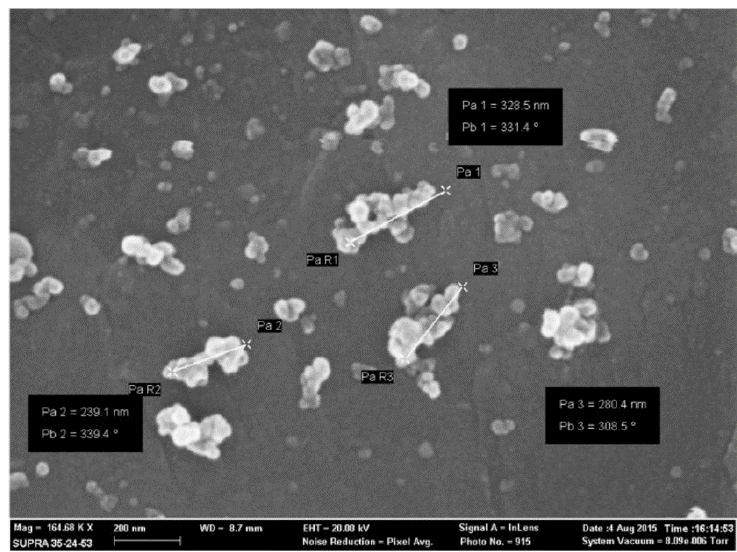
Figure 7. Scanning electron microscopy (SEM) image of particles from a sampling site located in an urban area.